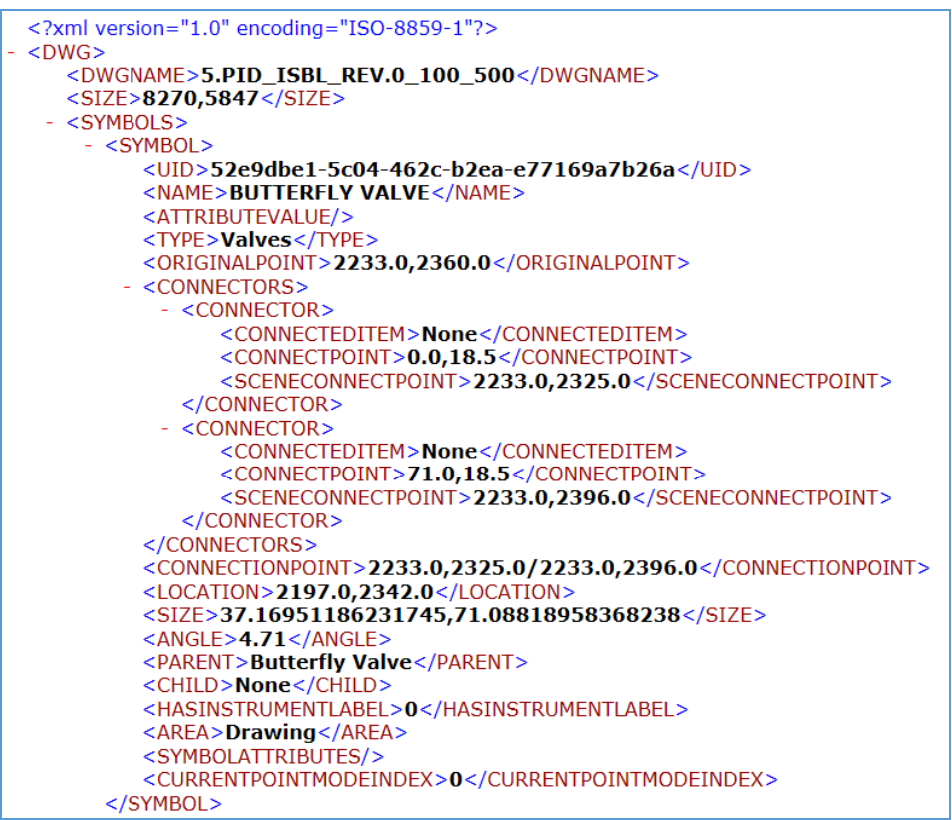
Figure 12. An example of an XML file used for recognition results.